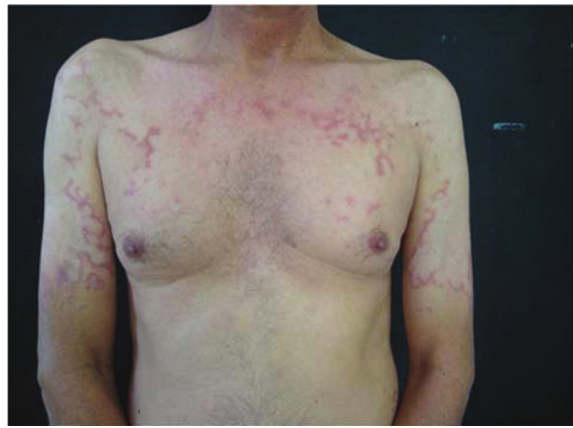
Figure 1: Atrophic plaques with slightly elevated border. Observe the annular pattern.